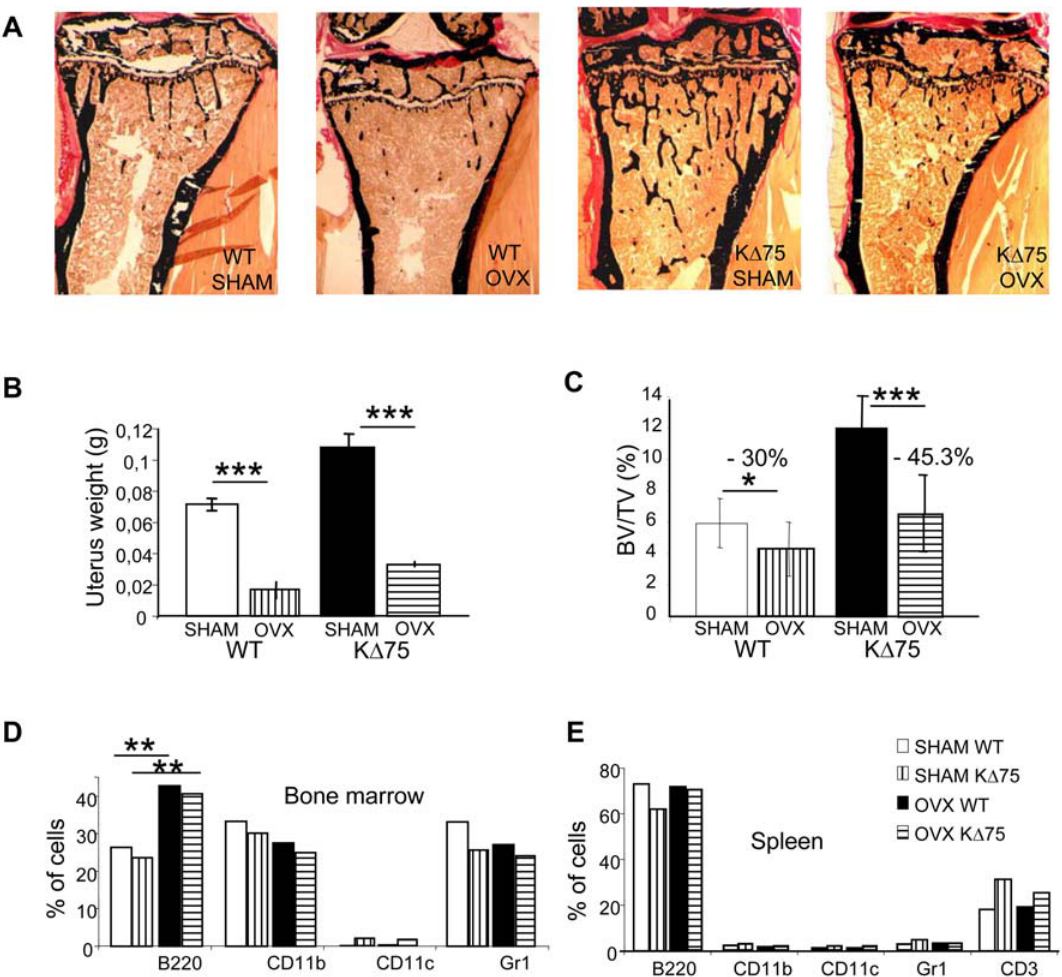
Figure 1. Ovariectomy of K D 75 mice triggers bone mass reduction. Ovariectomy (ovx) was performed on 8-week-old WT and K D 75 mice. 4 weeks later, ovariectomized and sham operated animals were sacrificed. (A) Histomorphometric analysis was performed on long bones after Von Kossa/Von Gieson staining. (B) Efficiency of ovariectomy was assessed by weighing uteri. (C) Bone mass was quantified. Results of the quantification show that WT mice lost 30% of bone mass after ovariectomy, whereas K D 75 mice lost around 45%. (D and E) Hematopoietic populations from bone marrow (D) or spleen (E) were characterized by flow cytometry using the B220 antibody for B lymphocytes; CD11b for monocytes; CD11c for dendritic cells; Gr1 for granulocytes and CD3 for T lymphocytes. (* p , 0.01, ** p , 0.001, *** p ,